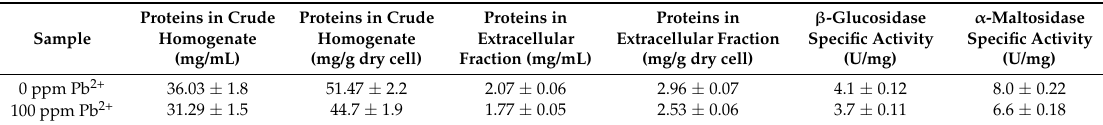
Table 2. Pb 2+ effect on protein contents and enzyme specific activities of T. thermophilus . Values are the mean of three experiments ±